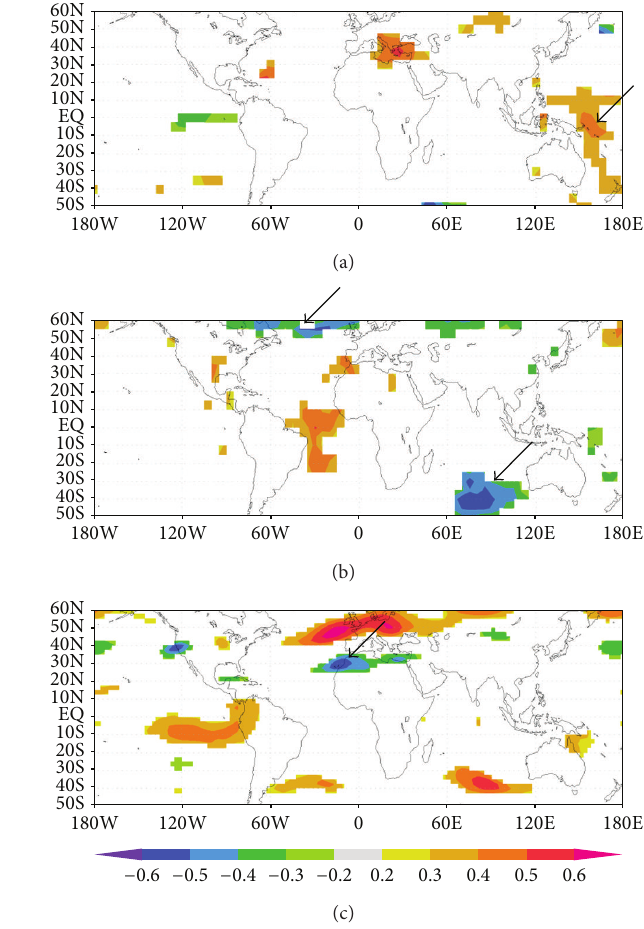
Figure 5: Correlation of ASO northern vegetation with MAM (a) Ts, (b) SLP, and (c) 200 U fields